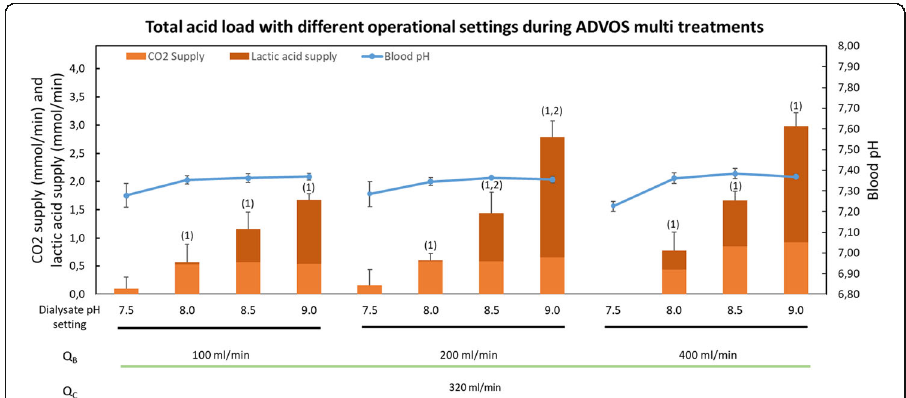
Fig. 3 Total acid load (CO 2 + lactic acid) with different operational settings during ADVOS multi treatments. CO 2 and lactic acid were supplied to maintain pCO 2 and blood pH between 35 – 45 mmHg and 7.35 – 7.45, respectively. A supply of 1 mmol/l of CO 2 corresponds to 22.5 ml/min in normal conditions. 1, p < 0.05 for CO 2 removal between consecutive dialysate pH settings among the same blood flow; 2, p < 0.05 for CO 2 removal between consecutive blood flows among the same dialysate pH